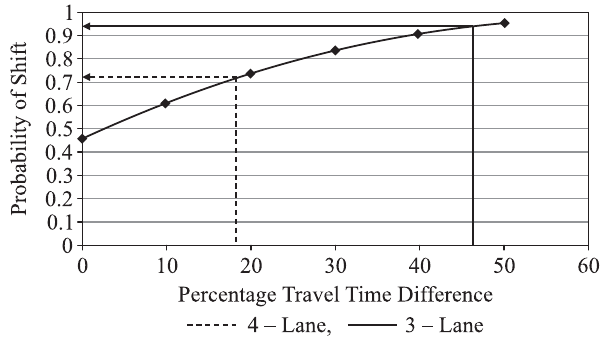
Fig. 3. Th e probability of the shift of auto-rickshaw users to